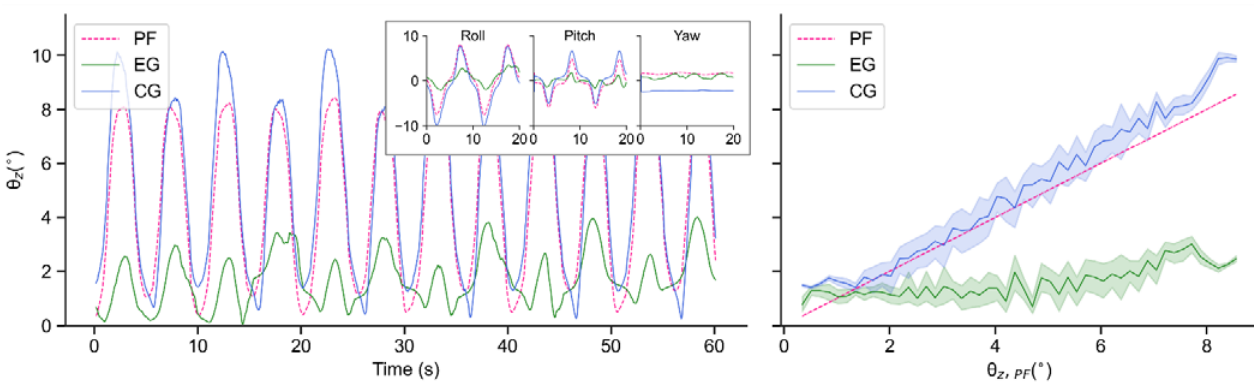
Figure 14. Tilt angles θ z of PF, EG and CG in real-world experiments when T = 10 s: Time-domain variations of tilt angles ( left ); Balance performance at varying tilt angles of PF ( right ).